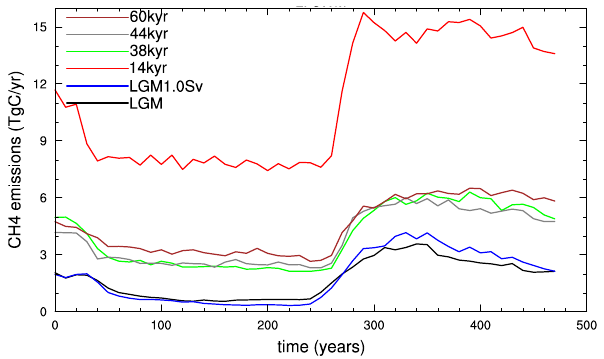
Fig. 6. Decadally averaged mean CH 4 emission time series in LPJ- WHyMe for the five different palaeoclimate simulations.